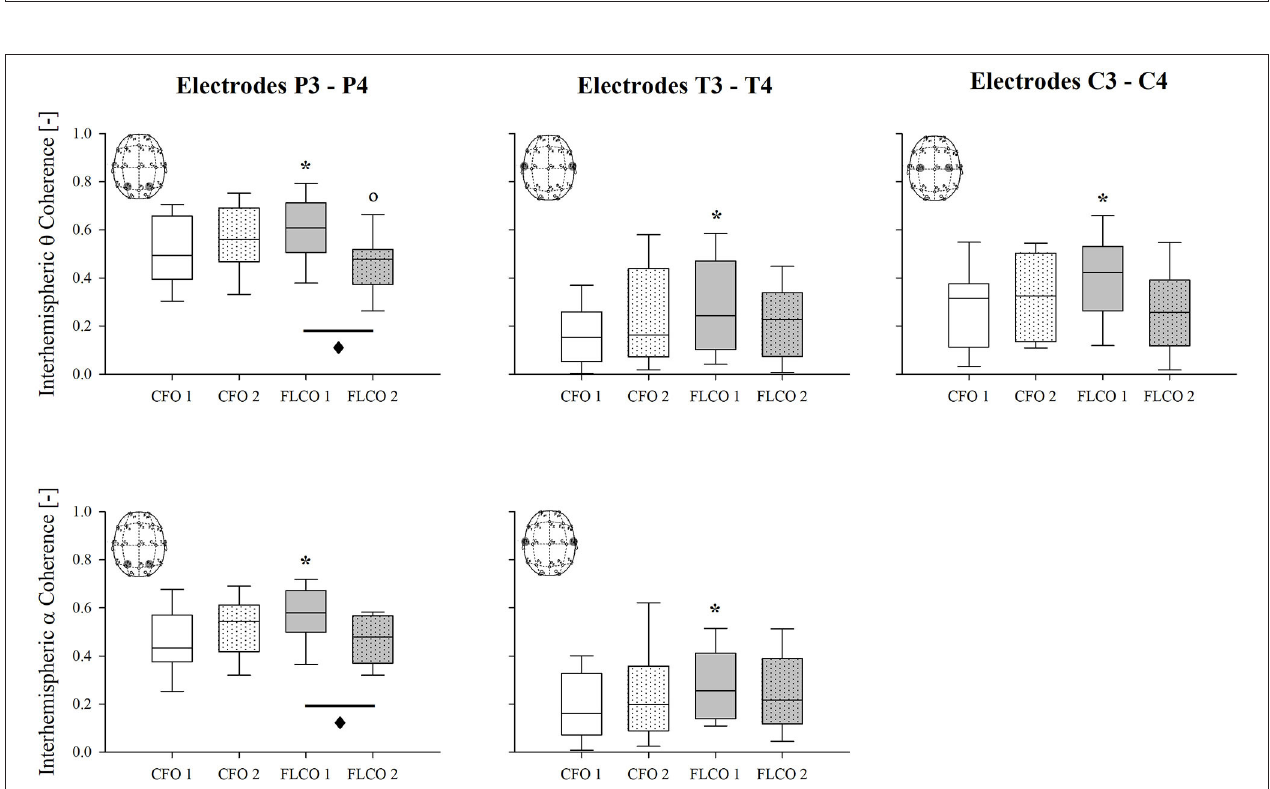
FIGURE 3 | A box-and-whisker plot representing the median (line within the box), the interquartile range (length of the box), the 90th and 10th percentiles (whiskers above and below the box) of the electroencephalographic derived interhemispheric theta coherence in P3-P4 (top left panel), T3-T4 (top central panel), C3-C4 (top right panel) electrodes and interhemispheric alpha coherence in P3-P4 (bottom left panel) and T3-T4 electrodes (bottom central panel) in operators who worked in COVID-19-free wards and departments (CFO, white) and in frontline COVID-19 operators during the pandemic (FLCO, gray) during the first (1) and the second sessions (2). * p < 0.05 CFO1 vs. FLCO1; ◦ p < 0.05 CFO2 vs. FLCO2; (cid:7) p < 0.05 FLCO1 vs. FLCO2.